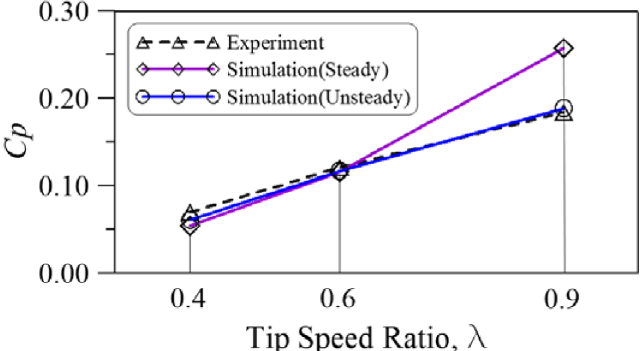
Fig. 5. Comparison of experimentally and numerically obtained power coef fi